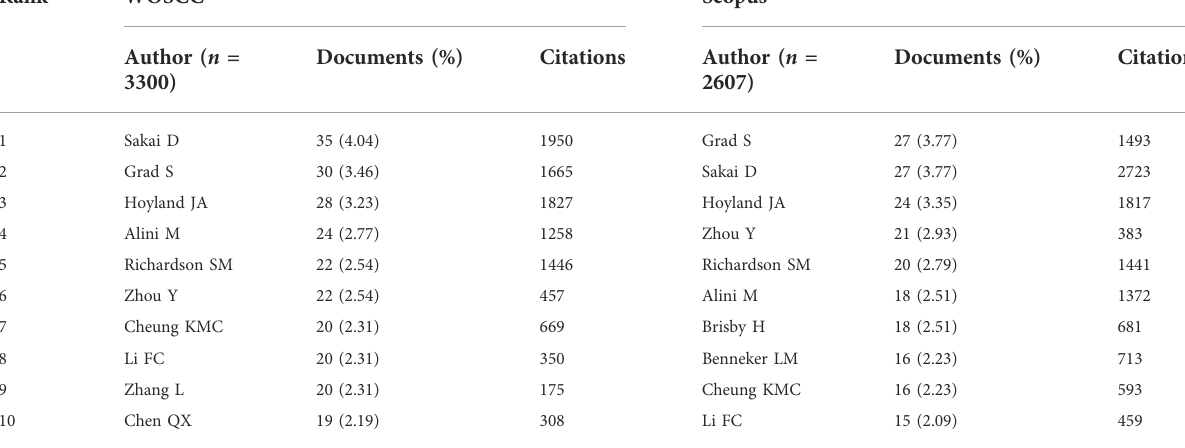
TABLE 2 Top 10 authors contributing to Publications in the WOSCC and Scoups